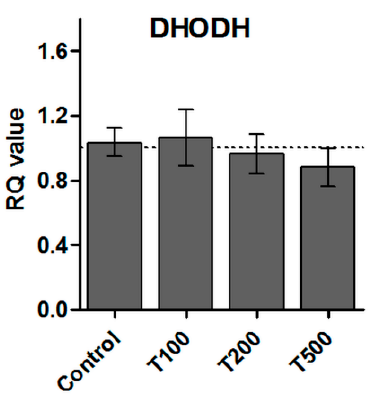
Figure 10. Relative mRNA expression level of DHODH in RPMI 8226 cells treated with teriflunomide (T) (100–500 µM) or DMSO as vehicle in control cultures for 24 h. ACTB and 18SN5 were used as reference genes. The obtained results were calculated as RQ values and presented as mean ± SD value of three independent experiments.